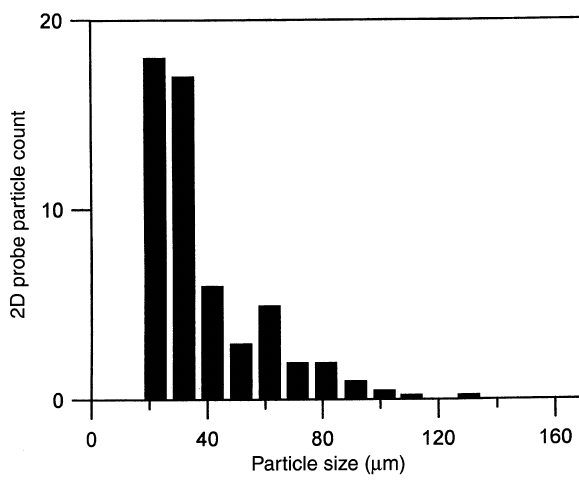
Fig. 16. Size distribution corresponding to